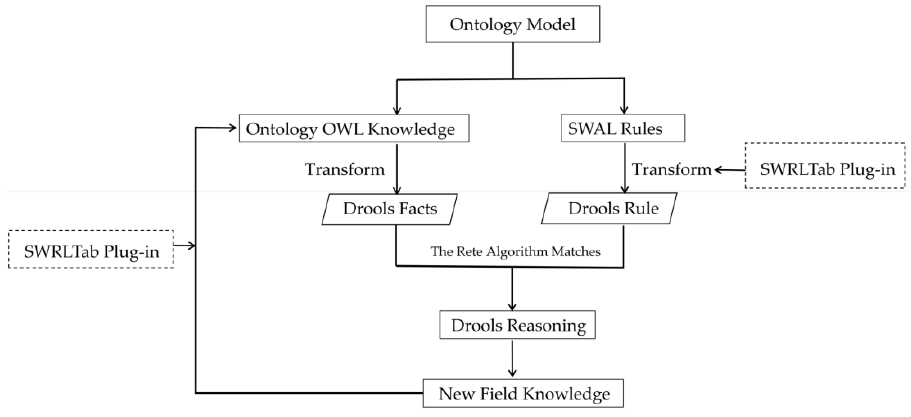
Figure 6. Ontology reasoning process based on Drools.